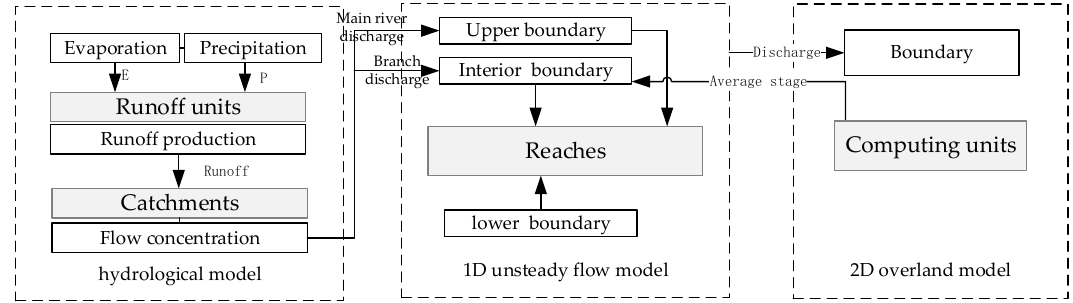
Figure 1. Hydrological-hydrodynamic model.